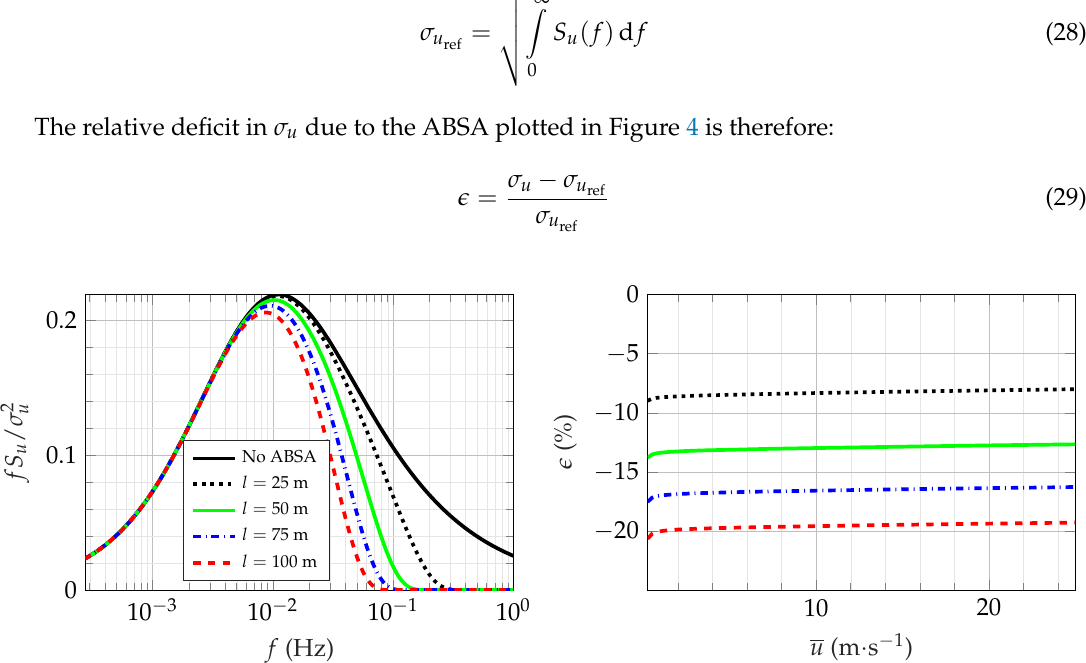
Figure 4. ( left ) influence of the along-beam spatial averaging (ABSA) effect of the WindCube on the measured normalized spectrum defined in the Handbook N400, using an arbitrary mean wind velocity s − 1 at z = 25m; ( right ) estimation of the corresponding deficit (cid:101) of the estimated standard u = 10m · deviation of the along-wind velocity due to the